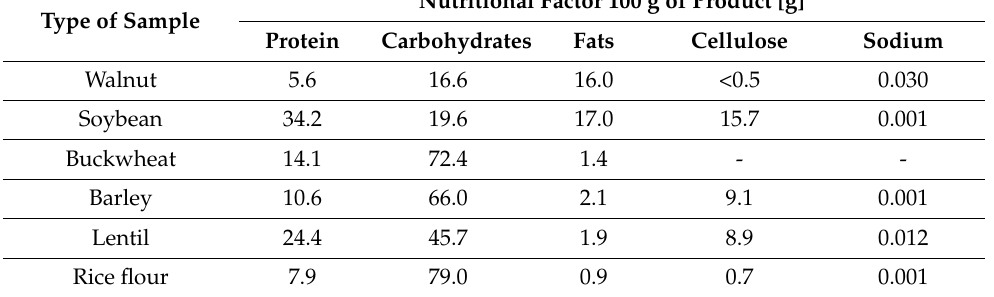
Table 1. Characteristic of the analyzed food samples according to information obtained from product